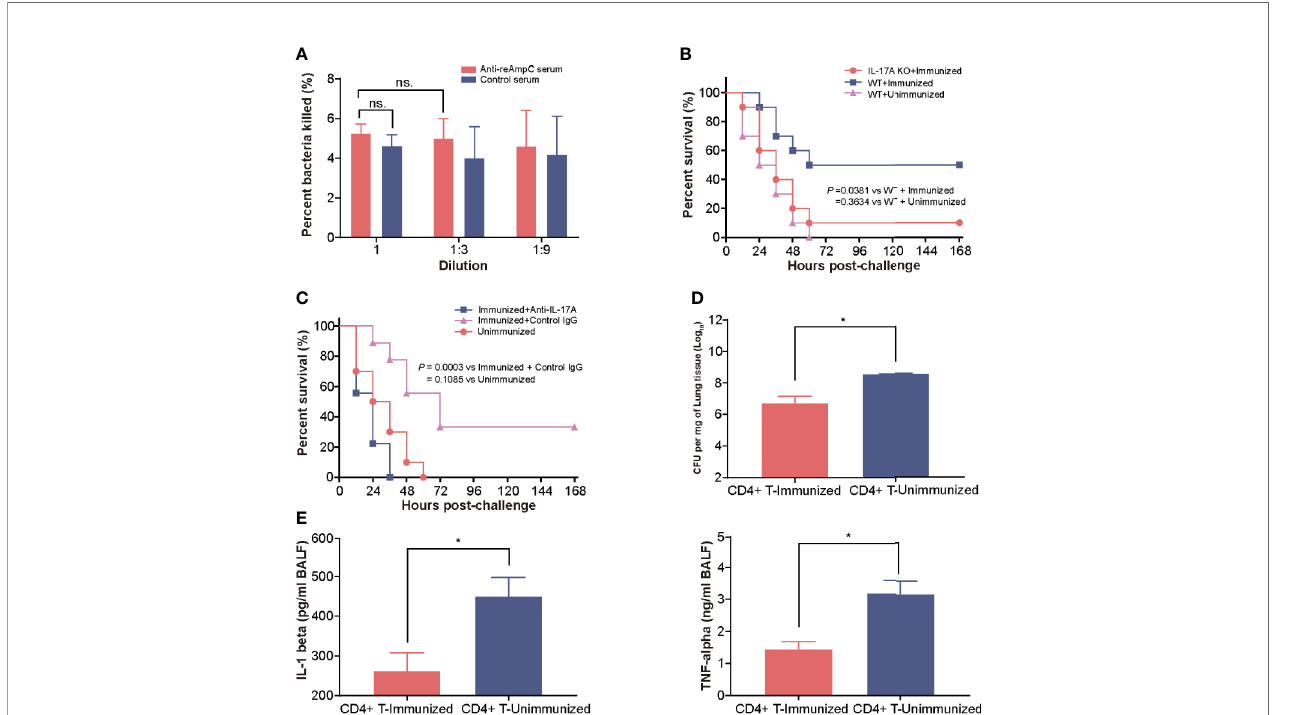
FIGURE 4 | The protection mediated by reAmpC relies on the Th17 response. (A) The opsonophagocytic killing activity of serum from immunized mice. The bar represents the percentage of killed bacteria in a series of dilutions. The data are presented as the mean ± SE. (B) WT (wild-type) mice or IL-17A knockout mice were immunized with reAmpC (n = 10) and then intratracheally challenged with PA XN-1. The bar represents the survival of mice in each group. (C) WT mice or IL-17A knockout mice (n = 10) were immunized with reAmpC and then intratracheally challenged with a lethal dose of PA XN-1. The bar represents the survival of mice in each group (n = 10). (D) CD4+ T cells from the lungs of reAmpC-immunized mice were transferred into naïve WT mice. Then, the mice were challenged with a sublethal dose of PA XN-1. The bar represents the average and SE of the log CFU of PA XN-1 per mg of lung tissue (n = 4). (E) Quantitative measurement of TNF- a and IL-1 b in the BALF of mice (n = 3). The data are shown as the mean ± SE. The “ * ” indicates a signi fi cant difference at P < 0.05. The “ n.s ” means “ no signi fi cant difference ”